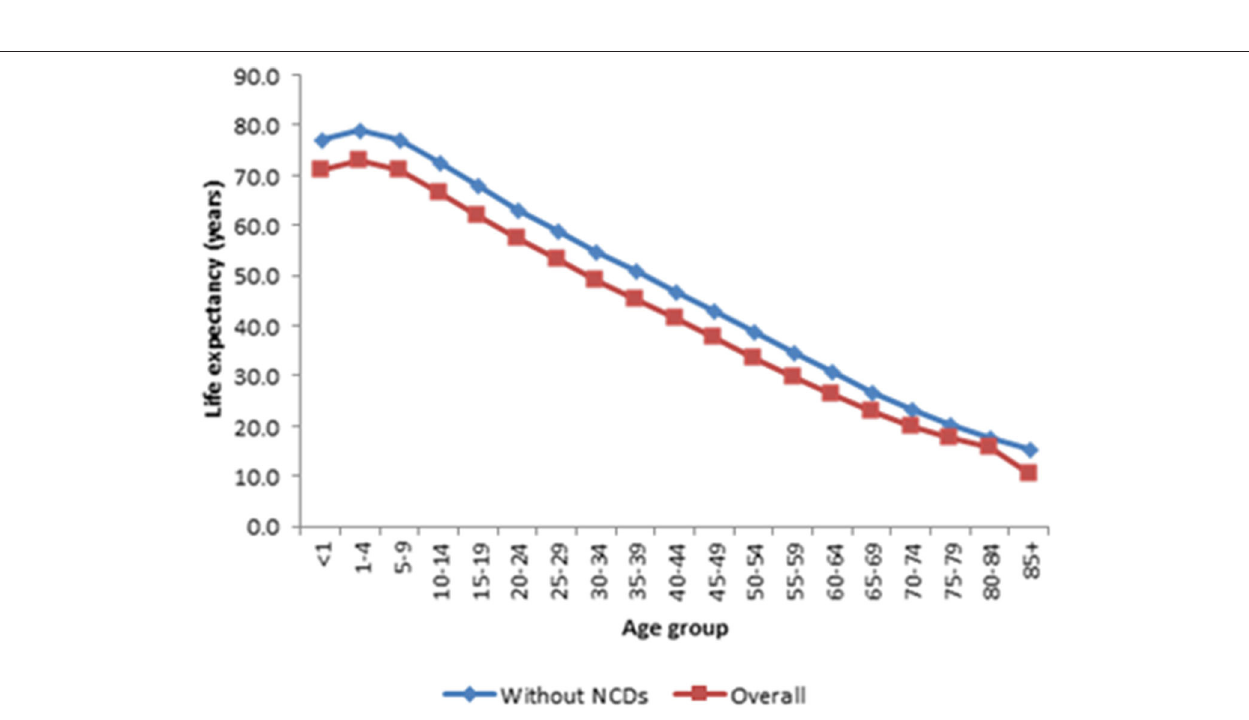
Frontiers in Global Women’s Health |